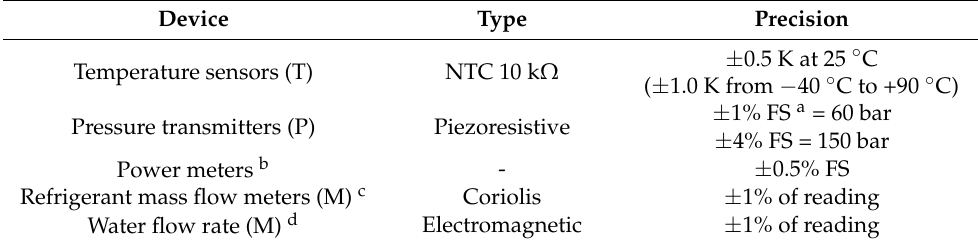
meters. Figure 1 indicates the position of the sensors in the refrigeration system, while Table 3 indicates the types and accuracy of these devices. The status of every single compressor and the inverter frequency are also acquired. The liquid level in the liquid receiver is monitored to detect the status of the liquid ejectors since its activation depends on the liquid level in the receiver. Table 3. Measurement devices implemented in the case study.